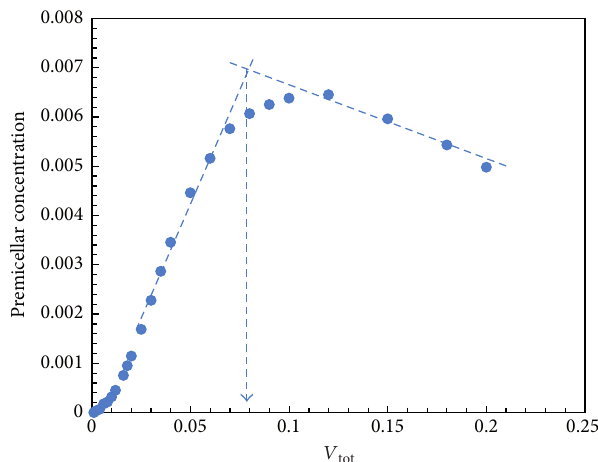
(cid:2395) (cid:85)(cid:80)(cid:85) F 2: Premicellar number density (summation of with ) of surfactant. ) versus total volume fraction ( tot T as a single chain surfactant. Maximum e graph belongs to H 𝑛𝑛𝑋𝑋 𝑛𝑛 concentrationisfoundneartoCMC.AerCMC,premicellesreduce 𝑛 ≤ 𝑛𝑛 ≤ 10 𝑉𝑉 3 3 rapidly.